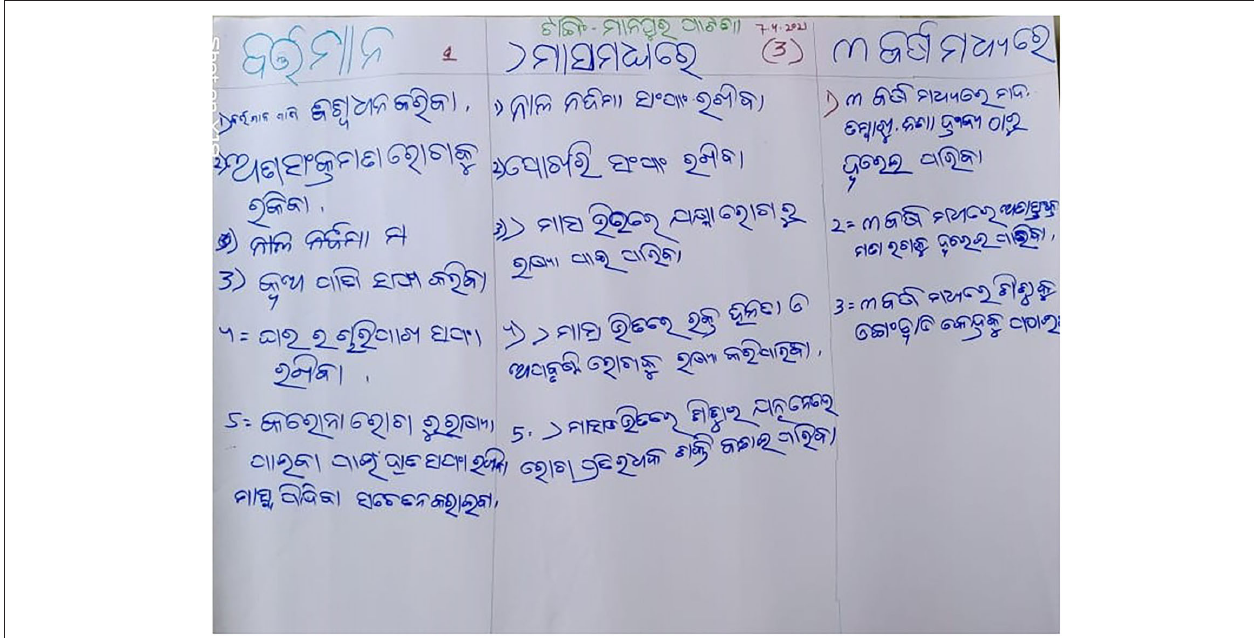
FIGURE 5 | NSL Chart prepared by a team.